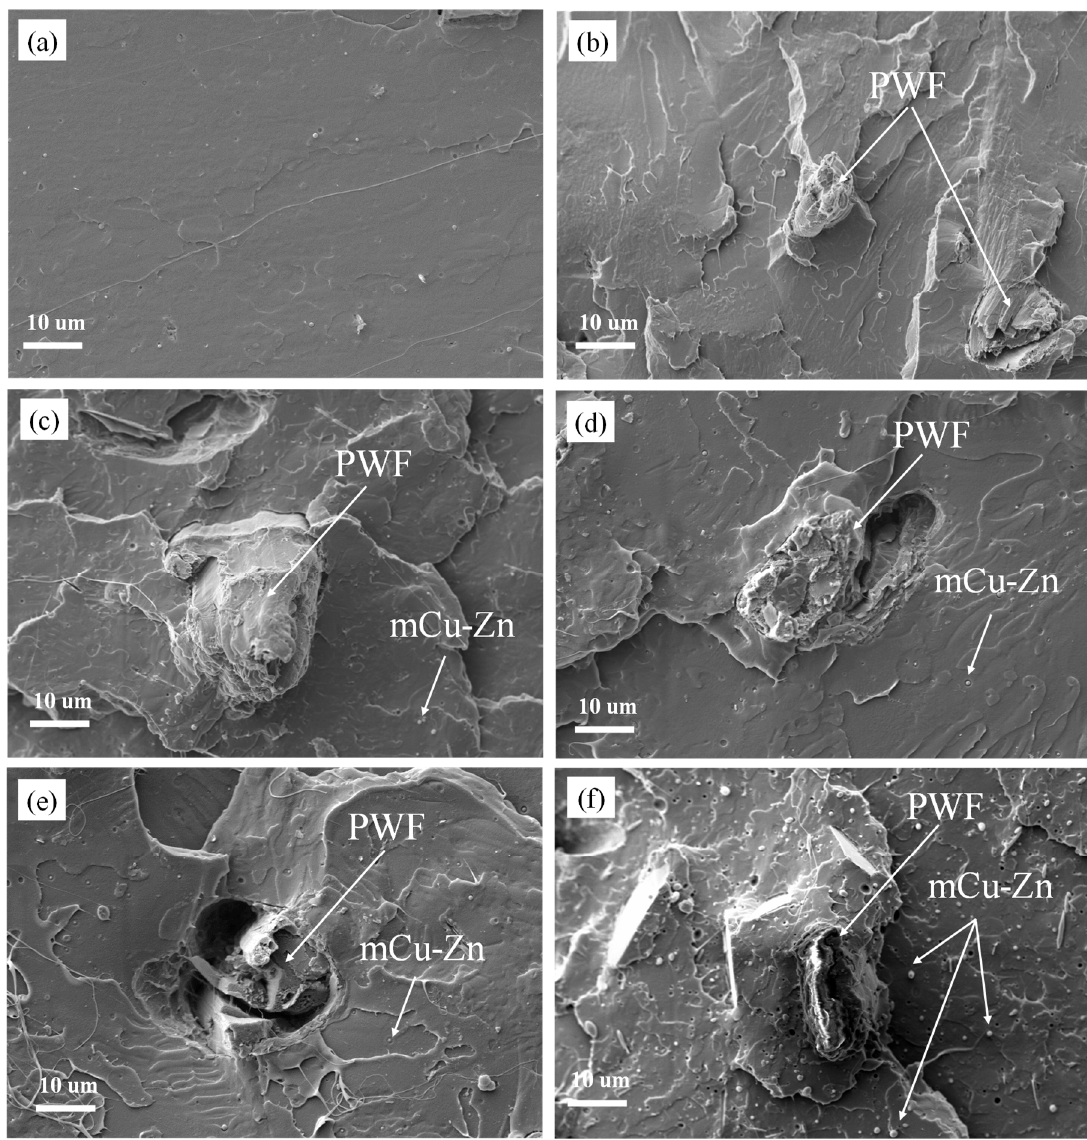
Figure 11. Scanning electron microscopy (SEM) images of the fracture surface of the composites: ( a ) Pure PLA, ( b ) PLA ‐ 5PWF, ( c ) PLA ‐ 1mCu ‐ Zn, ( d ) PLA ‐ 2mCu ‐ Zn, ( e ) PLA ‐ 3mCu ‐ Zn, ( f ) PLA ‐ 4mCu ‐ Zn.